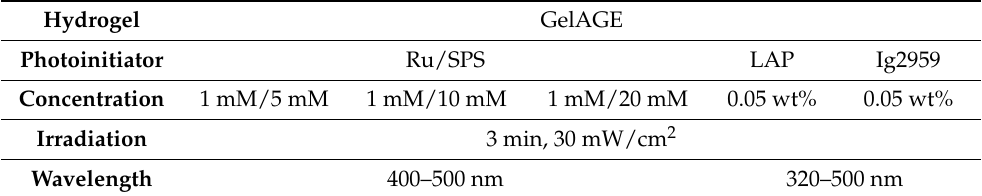
Table 1. Formulation of photoinitiators and irradiation condition to crosslink GelAGE. Hydrogel GelAGE